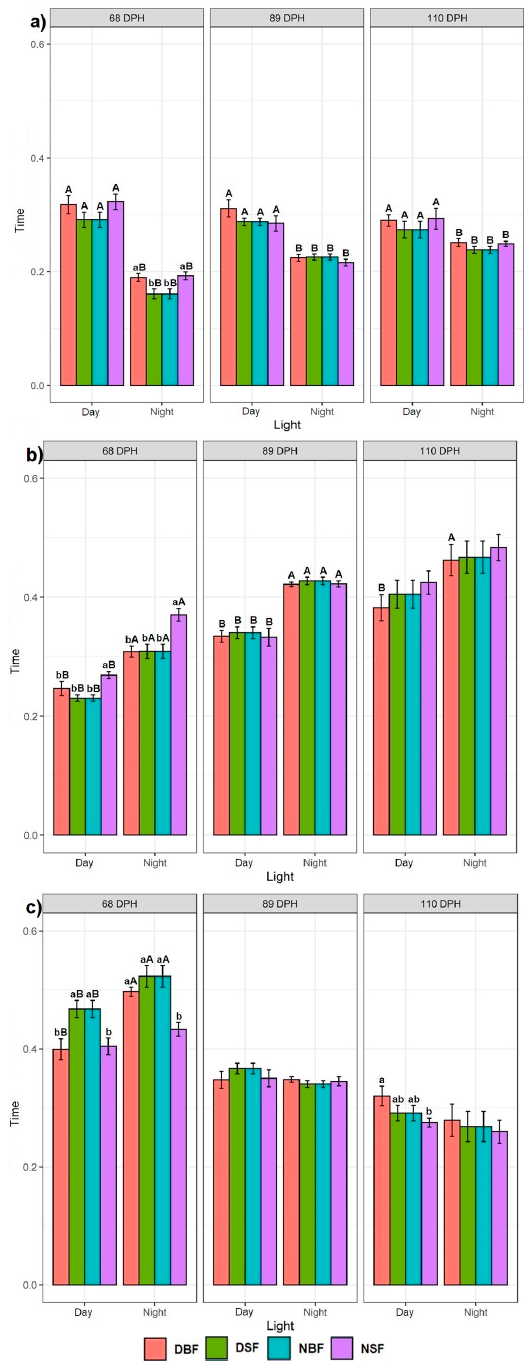
Figure 2. Effect of different feeding applications: DBF—day bottom feeding; DSF—day surface feeding; NBF—night bottom feeding; NSF—night surface feeding with day and night regimes on the Siberian sturgeon swimming preference: ( a ) at 25% bottom of the tank; ( b ) at 50% of the tank; ( c ) at 25% surface, which was recorded every three weeks at 68, 89 and 110 dph. Letters denote a significant difference, where the lowercase shows the difference between feeding applications for day or night regimes per recording day for each tank section. The uppercase letters show the difference for each feeding application between day and night per recording day for each tank